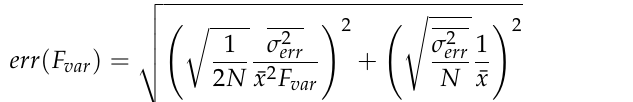
Table 2. Details of the PL and LP model fits for the three epochs. Here, γ -ray flux is in the units of 10 − 6 ph cm − 2 s − 1 . Epoch